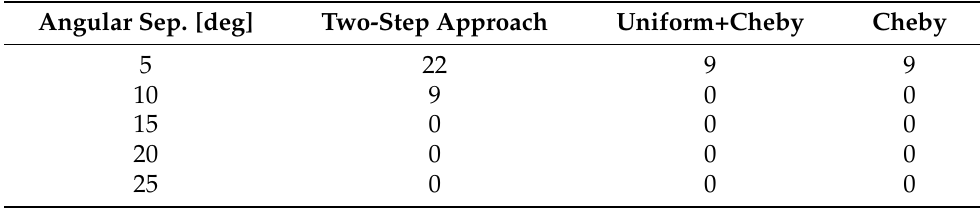
Table 2. Number of failures in 500 trials with respect to angular separation for the three-signal snapshots, and 500